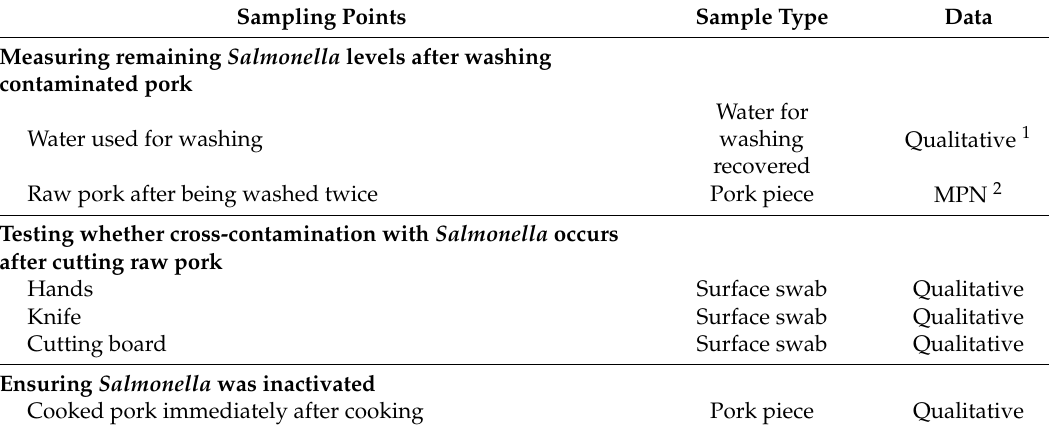
Figure 1. Steps and scenarios in experiment of Salmonella enterica cross-contamination. Timing associated with the steps: 1 after washing inoculated pork twice, 2 just before boiling after washing pork twice, 3 after primary cut of pork and washing once, 4 after boiling pork (wait until cool down) without any process, 5 just before slicing cooked pork, 6 after finishing slicing the cooked pork pieces, and * disinfection before slicing. Table 1. Investigation of Salmonella enterica during cross-contamination experiments.